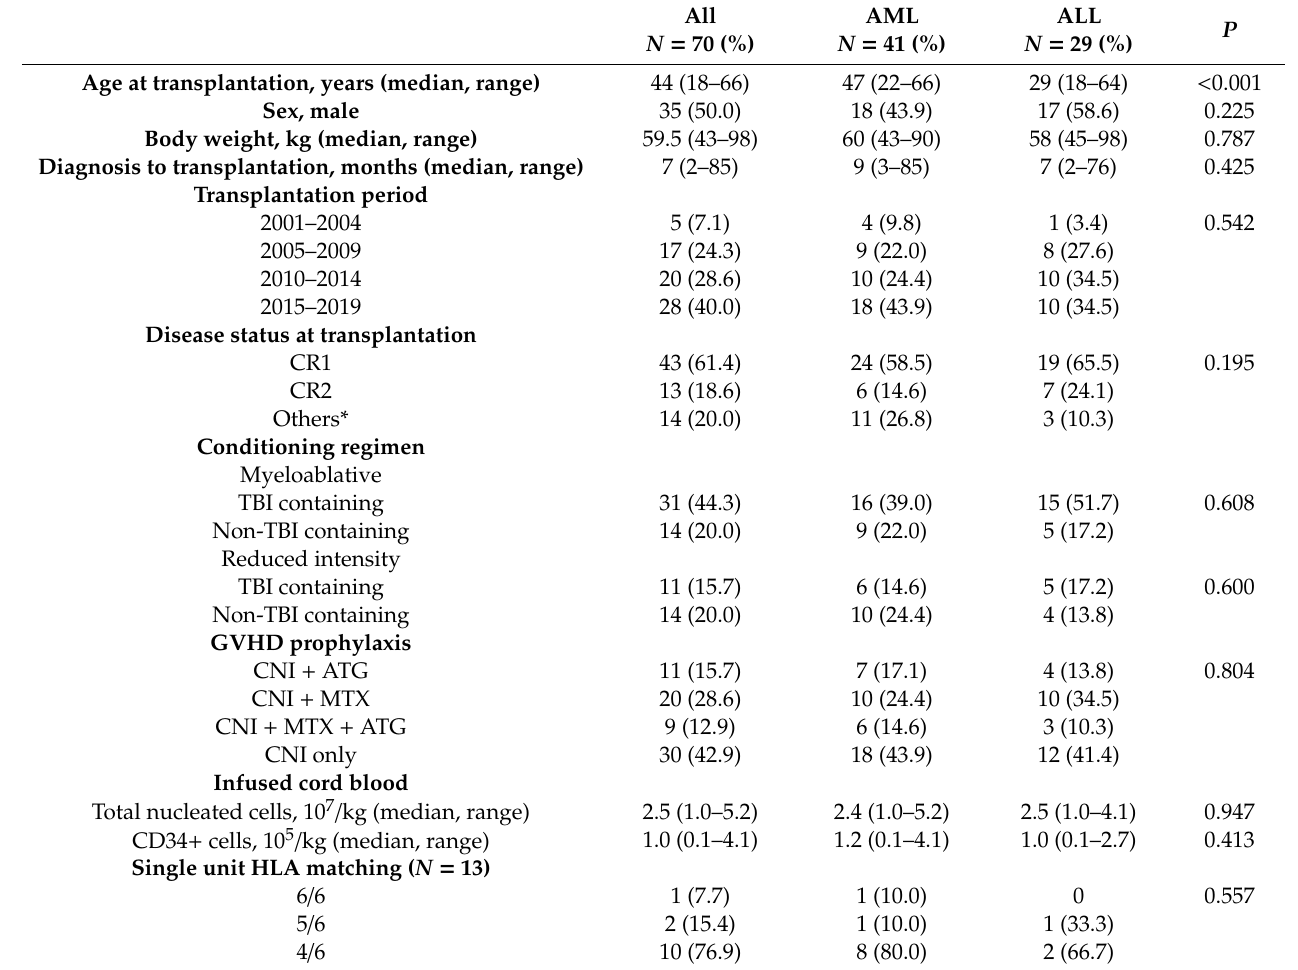
Table 1. Baseline